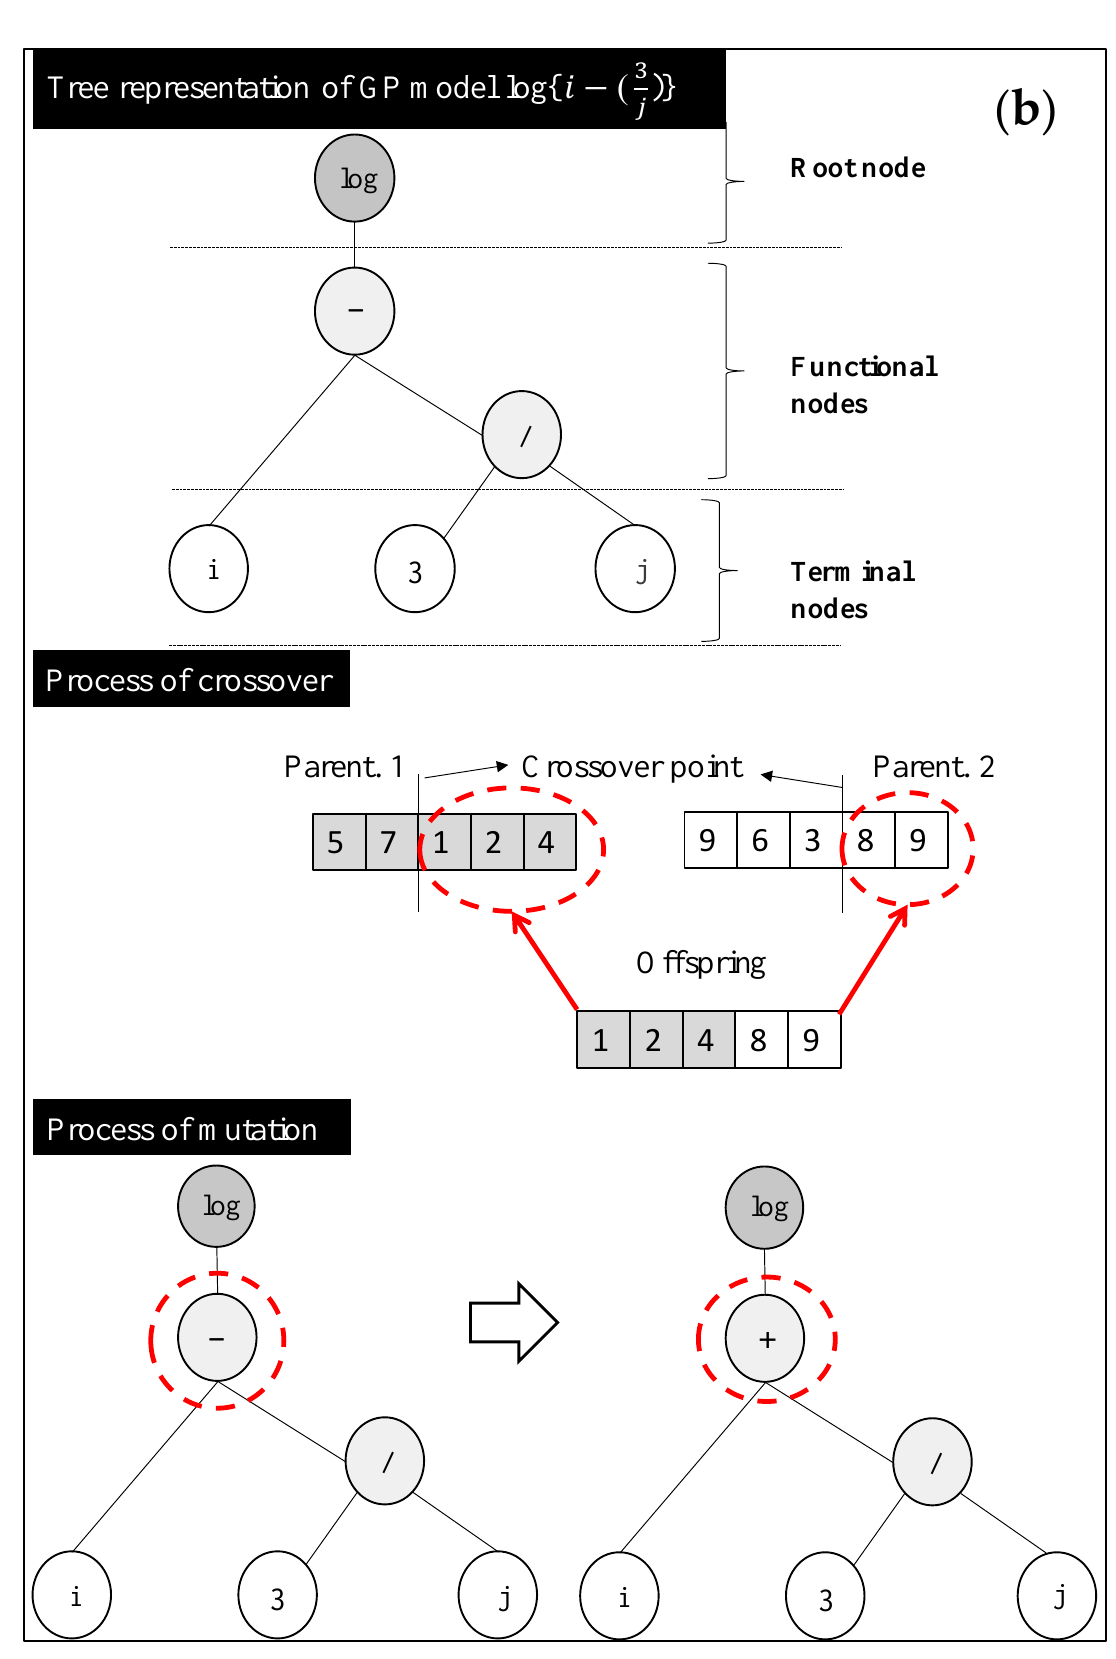
Figure 1. ( a ) Basic working process of gene expression programming (GEP) [64] . ( b ) Expression tree, crossover, and mutation processes in a representative GEP model [42].